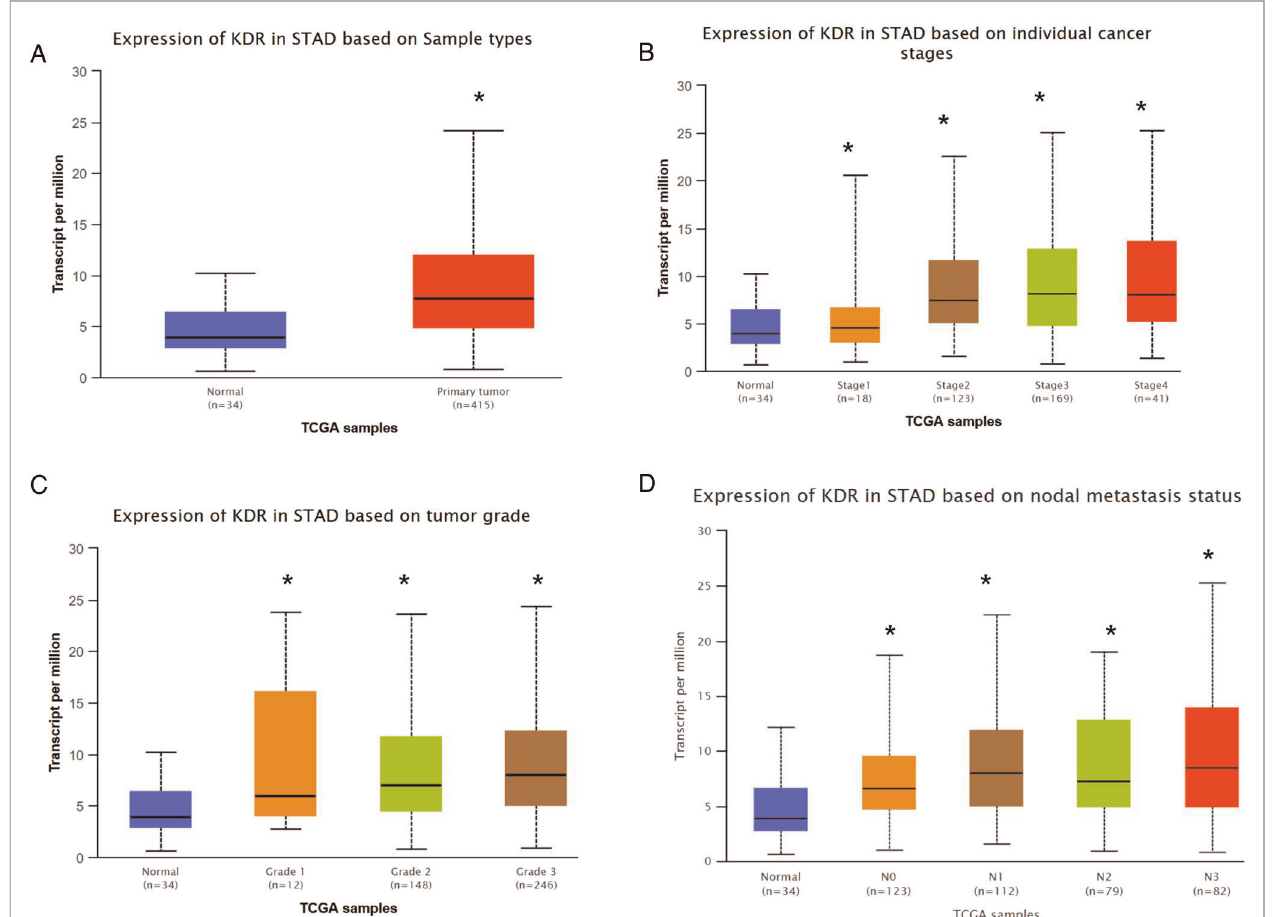
FIGURE 2 | VEGFR expression in GC. ( A ) VEGFR expression based on sample type. ( B ) VEGFR expression based on individual cancer stages. ( C ) VEGFR expression based on tumor grade. ( D ) VEGFR expression based on nodal metastasis status. * p